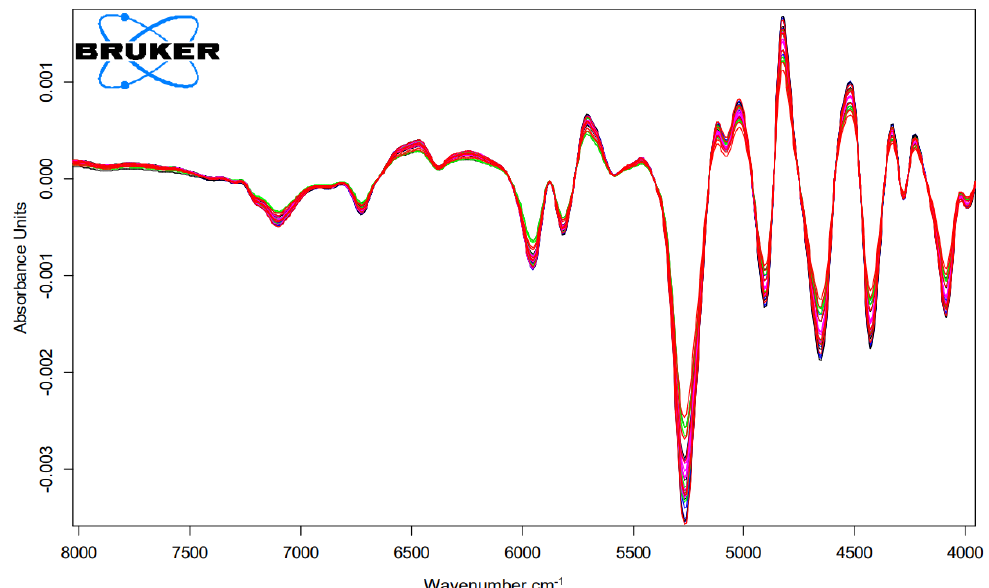
Figure 3. First derivation of FT-NIR-spectra of hair tresses after 3 times bleaching and dyed with matcha and iron-(II)-lactate with n = 5.